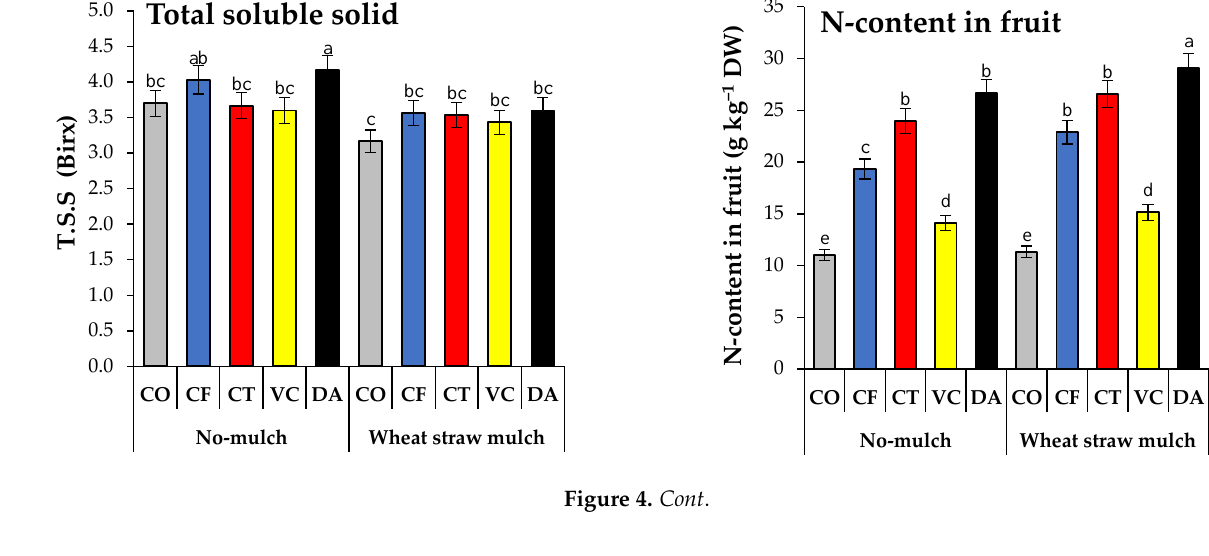
Figure 4. Effect of organic amendments and mulching system on squash fruits. CO = Control (without fertilization), CF = Recommended mineral fertilization (112 kg N ha −1 + 50 kg P 2 O 5 + 75 kg K 2 O ha −1 ), CT = Compost (7.5 t ha −1 ), VC = Ver- micompost (7.5 t ha −1 ), DA = Dry Azolla pinnata (3.75 t ha − 1 ). Different letters indicate significant differences according to Duncan’s multiple range test at p ≤ 0.05. Data are means of three replicat es ± SE. 4. Discussion Agricultural waste has increased dramatically in recent years due to the increase in agricultural production and thus the burden has increased on environmental scientists to devise innovative methods to recycle the agricultural waste [1,2]. Converting the agri- cultural waste into organic fertilizers is an ideal solution to reduce environmental prob- lems and at the same time increase the soil fertility [3,4]. In the current study, wheat straw was used to cover the soil to increase the productivity of squash with the use of organic fertilizers instead of the chemical ones. The application of compost, vermicom- post, and dry Azolla to the soil increased the growth and yield of squash plants. Moreo- ver, the results of the yield and fruit quality were also controversially close to those ob- tained from the mineral fertilization. The use of Azolla to fertilize the soil and wheat straw mulch led to obtain the best results in yield, growth, and quality. The studied or- ganic fertilizers were able to significantly increase the availability and uptake of the es- sential plant nutrients, which led to an increase in photosynthesis and thus increased the growth of squash plants. These results regarding the improvement in soil quality as a result of organic fertilization are consistent with those obtained from the studies of Alharbi et al. [4] and Rekaby et al. [43]. Organic fertilizers increase the organic matter content and nutrient availability in soil [43,44]. Moreover, organic fertilizers play